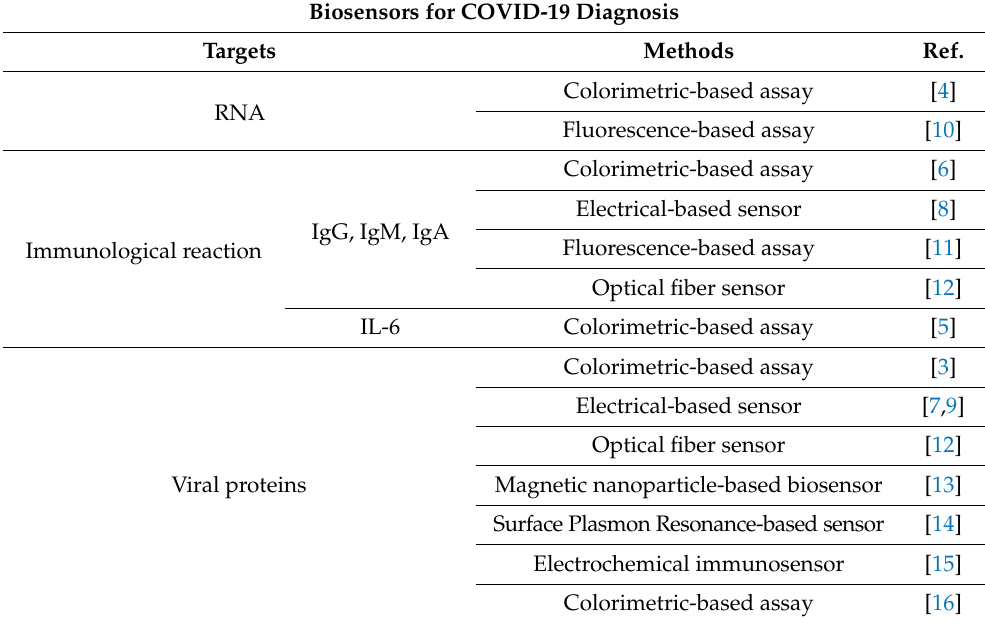
Table 1. Different targets that have been applied for COVID-19 diagnosis include detection of viral RNA, products of immunological reactions, i.e., IgA, IgG, and IgM antibodies and interleukin 6 (IL-6), as well as viral proteins E, M, S, and N.